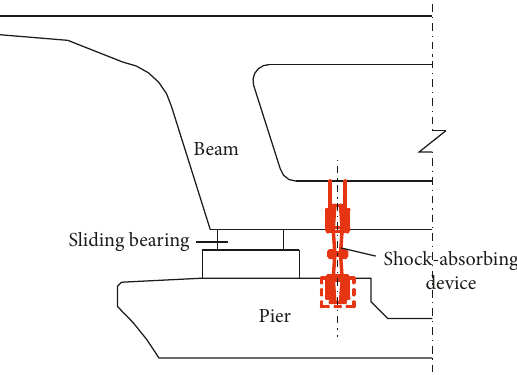
Figure 3: Shock-absorbing steel bar